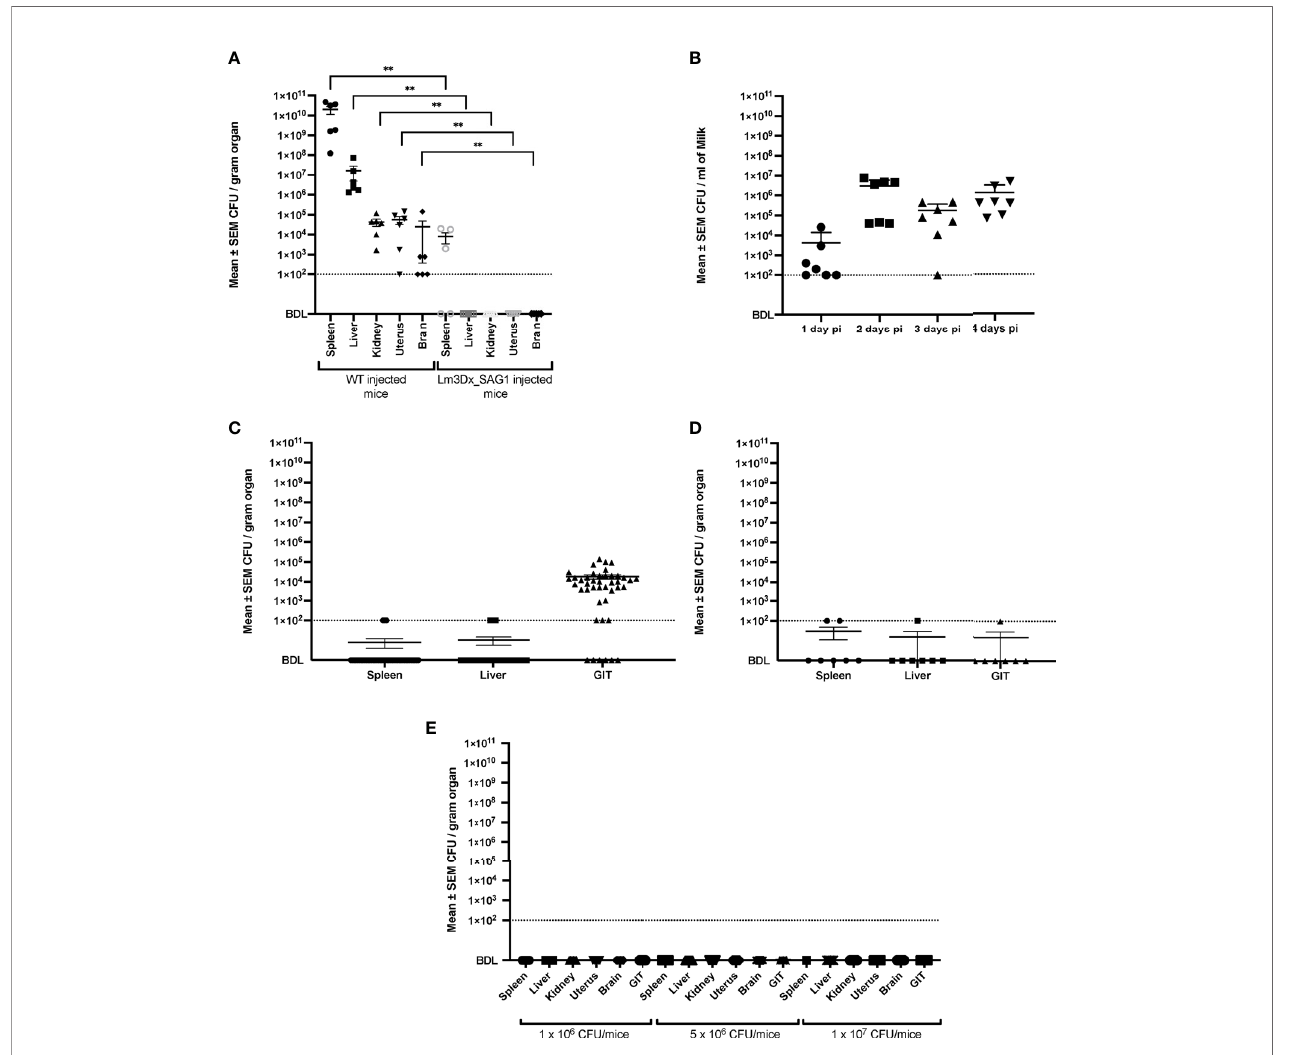
FIGURE 4 | Recovery of WT and Lm3Dx_SAG1 L. monocytogenes from internal organs and milk. (A) Mean ± SEM CFU/gram organ in adult non-pregnant mice 36h following i.m. inoculation with 1 x 10 7 WT or Lm3Dx_SAG1. Asterisks indicate signi fi cant differences to the WT group: **P ≤ 0.0021 (Mann Whitney-U test). (B) Excretion of Lm3Dx_SAG in milk during 4 days following i.m. vaccination of lactating dams, given as mean ± SEM CFU/ml (experiment 2). (C) Mean ± SEM CFU/ gram organ of pups feeding milk from Lm3Dx_SAG1 dams (experiment 2). (D) Mean ± SEM CFU/gram organ in lactating dams 4 days following vaccination with 1 x 10 7 Lm3Dx_SAG1 (experiment 2). (E) No CFU were recovered from internal organs of adult mice two weeks following the third vaccination with Lm3Dx_SAG1 (experiment 1). The data points represent individual mouse values. The detection limit for all experiments was set to 10 2 CFU/gram organ or milk following enrichment (dashed line). BDL, Below detection